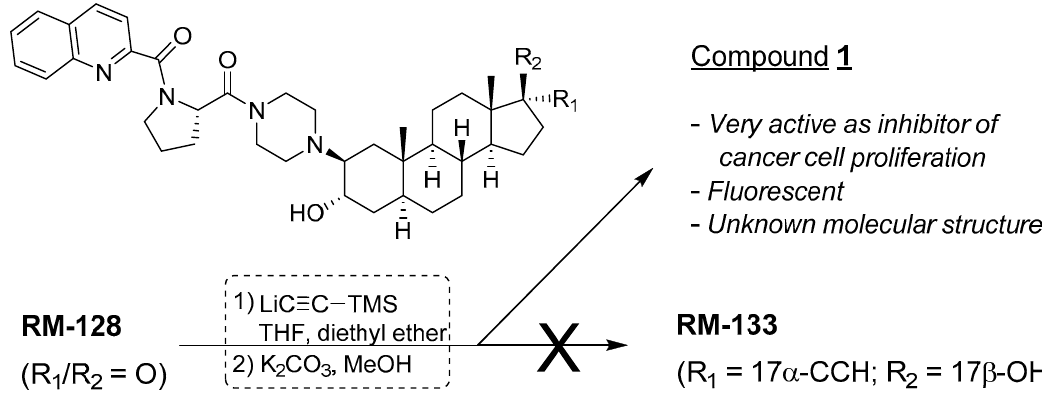
Figure 1. Unexpected formation of an unknown biologically active steroid derivative.